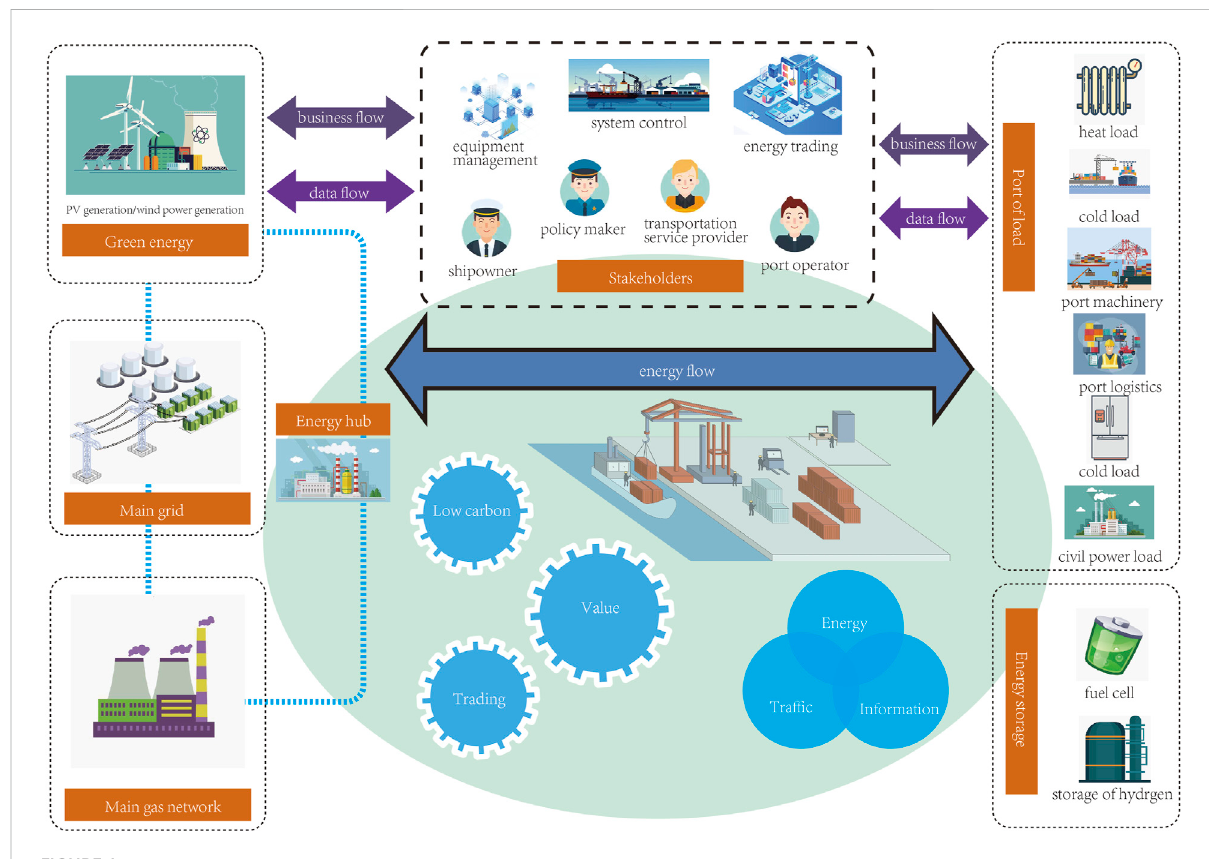
FIGURE 1 Integrated port energy